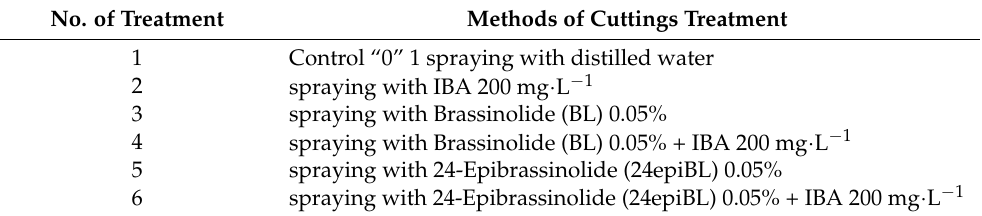
Table 1. A list of treatments in the experiment. No. of